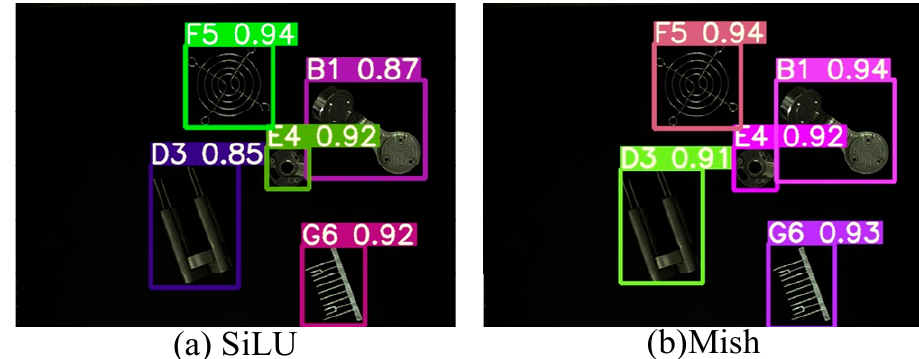
Figure 14. Results of Traditional YOLOv5.